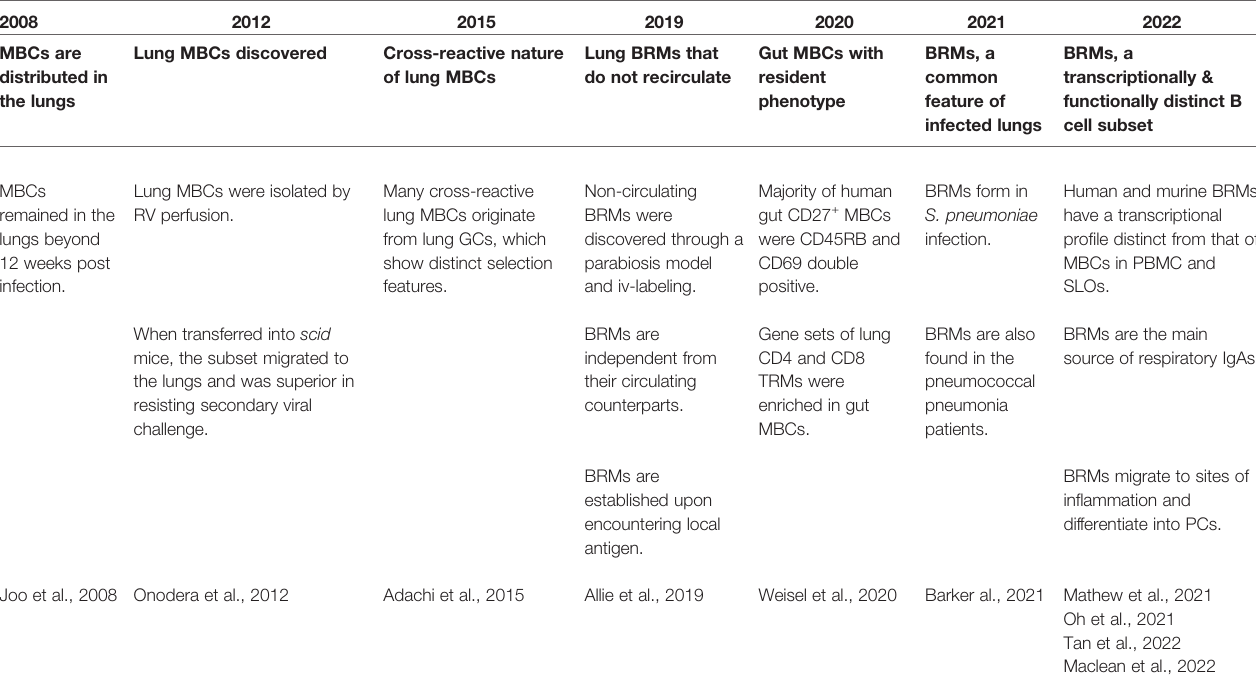
TABLE 1 | Brief history of BRM